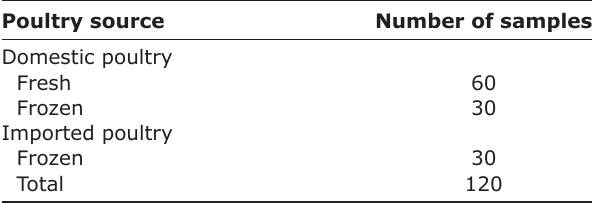
Table-1: Sources and numbers of poultry meat samples collected from Jordanian markets for investigation of sulfamethazine residues.